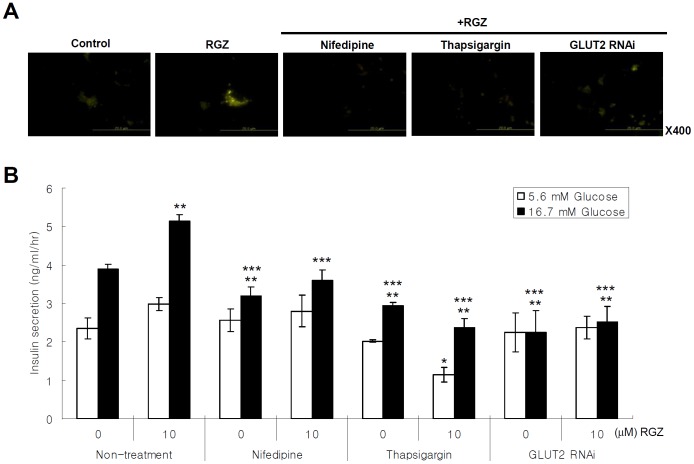
RGZ induces intracellular calcium mobilization from extra- and intra-cellular sources.(A) Effects of nifedipine (10 mM), thapsigargin (0.1 µM), and GLUT2 sequence-specific silencing with RNAi on 10 µM RGZ-induced intracellular calcium mobilization and (B) insulin secretion (ANOVA within same glucose conditions: n = 4, *
P<0.01 vs. RGZ treatment with 5.6 mM glucose; **
P<0.05 vs. non-treatment with 16.7 mM glucose; and ***
P<0.01 vs. RGZ treatment with 16.7 mM glucose) (C) Immunoblot for GLUT2 expression with 10 µM RGZ treatment and/or adenoviral PPAR-γ overexpression.